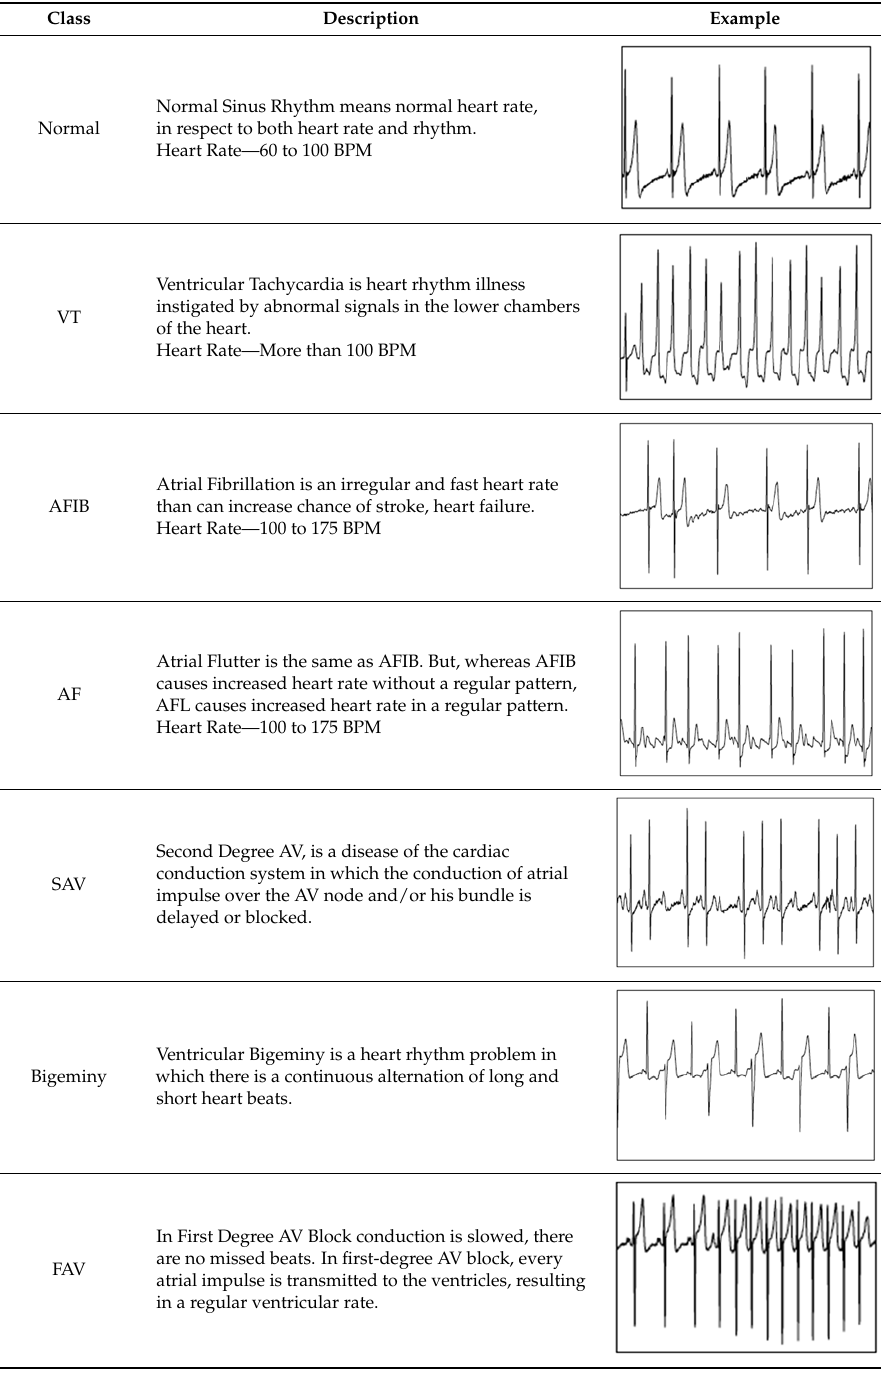
Table A1. A list of all arrhythmia types which the model classifies. For each arrhythmia, we give the label name, a more descriptive name, and an example chosen from the training set. We also give some description of each arrhythmia type [23].